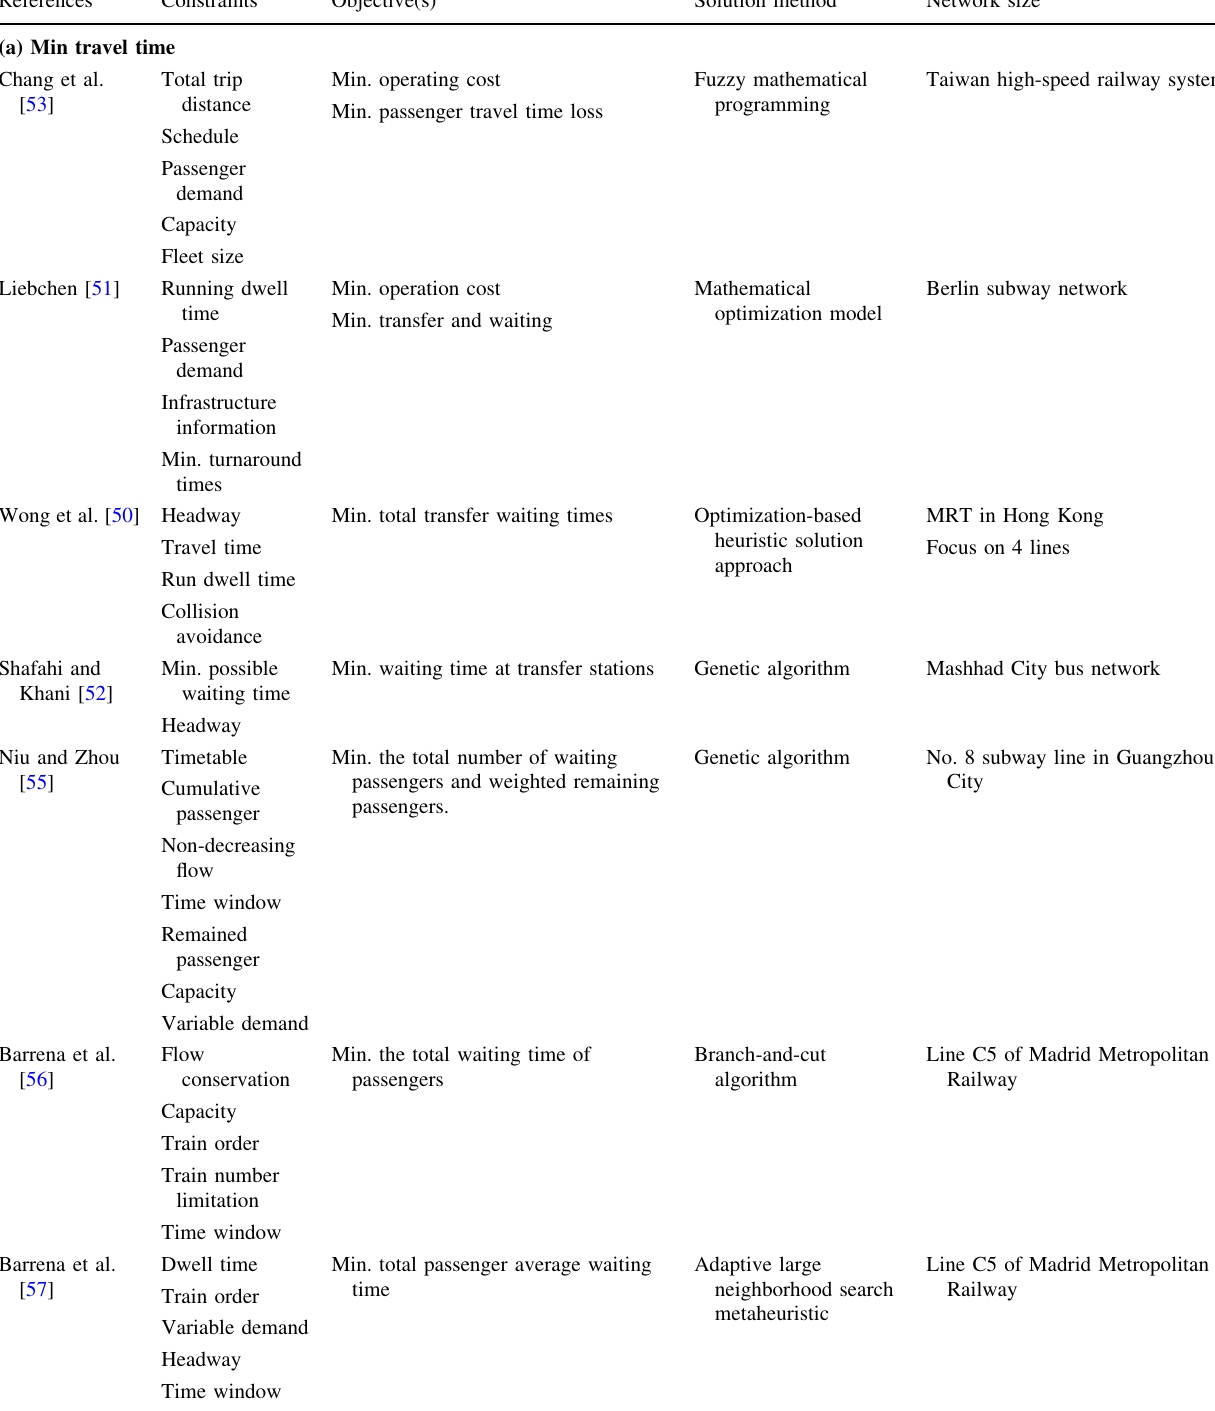
Table 2 A summary of urban transit network schedule